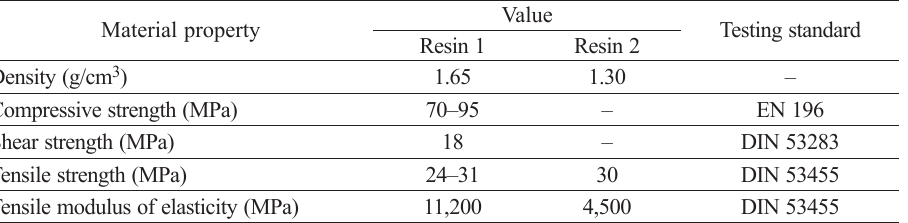
Table 2. Properties of adhesives (from manufacturer)